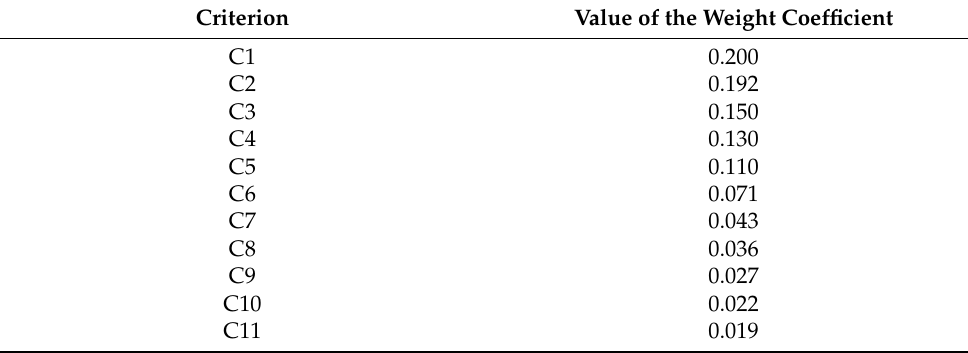
Table 5. The values of the weight coefficients of the